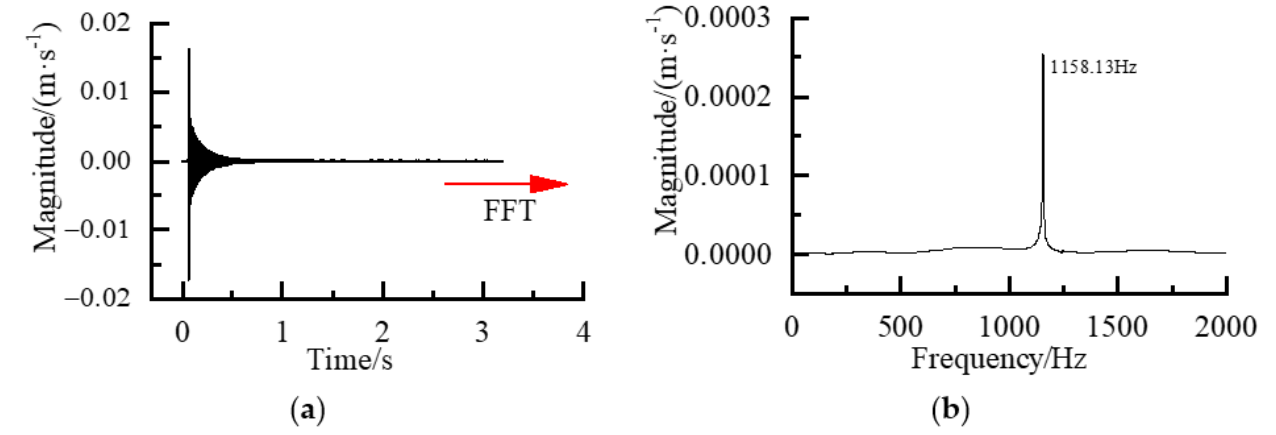
Figure 1. Typical test curve of short suspender measured by LDV (Sample 1 under tension force of 8.41 kN). ( a ) Vibration curve in time domain; ( b ) Vibration curve in frequency domain (the natural frequency is 1158.13 Hz).